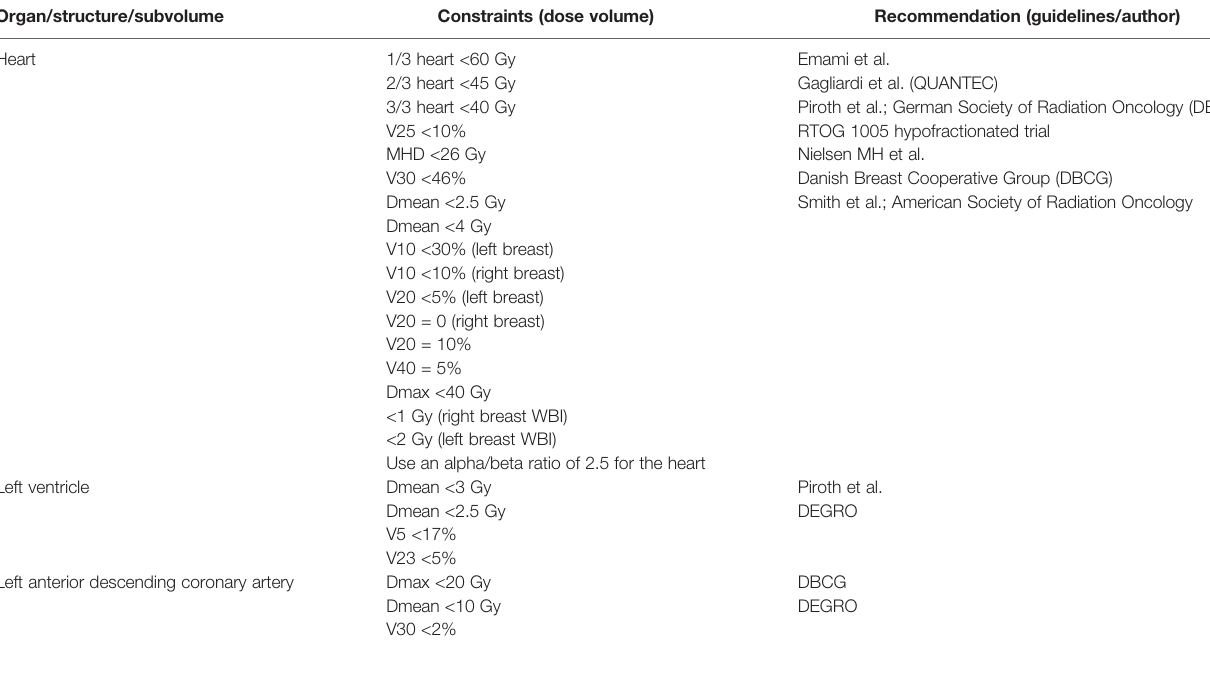
TABLE 1 | Dose constraints for whole heart and heart anatomical structures for breast cancer radiotherapy (48 –